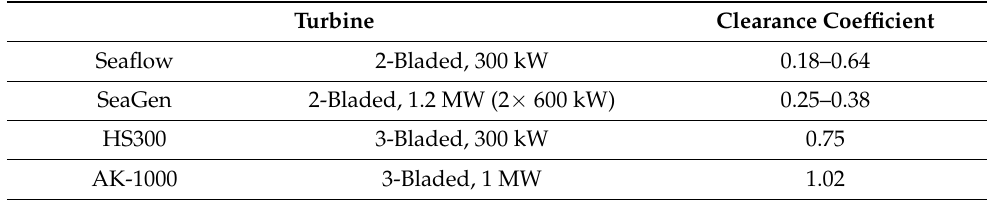
Table 1. Clearance coefficients for commercial HAHTs.